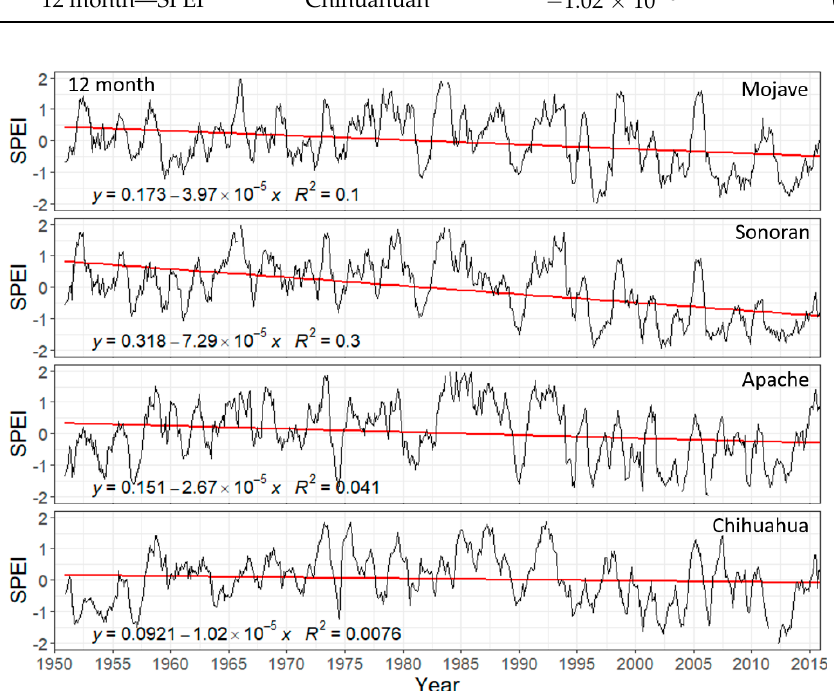
Table 2. Differences between historic mean SPEI (1950–1999) and mean SPEI of the early 21st cen- tury (2000–2015) significant at p < 0.05 using 12 − month SPEI data obtained from Global Drought Monitor for all four ecoregions [31].